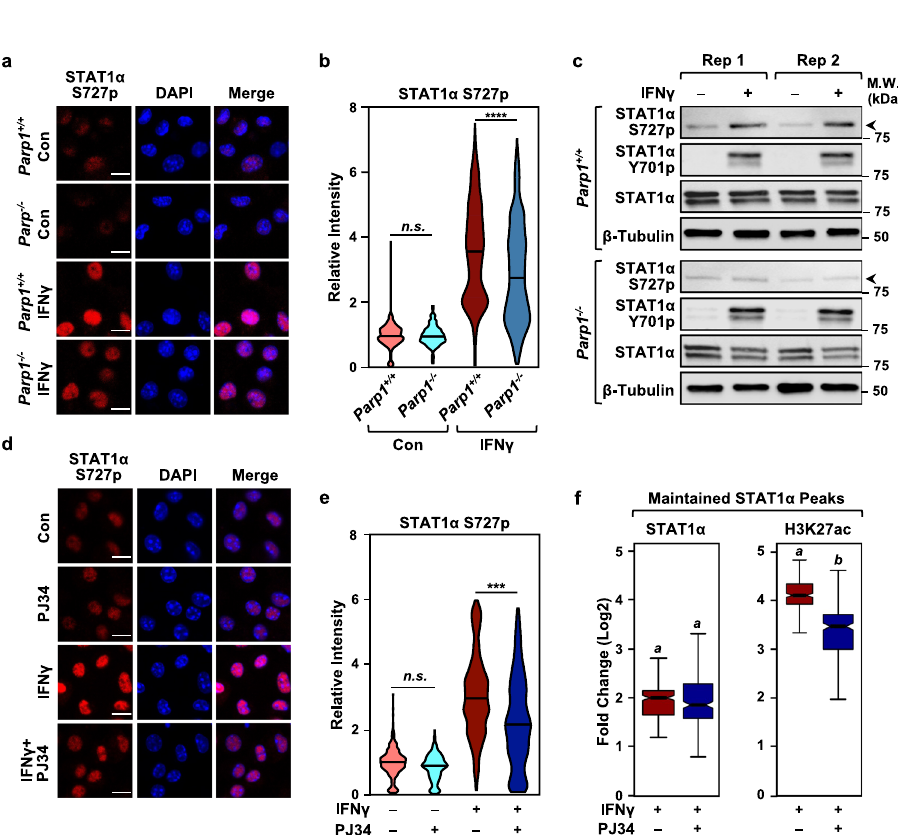
Fig. 3 PARP-1 catalytic activity promotes the phosphorylation of STAT1 α on Serine 727. a PARP-1 deletion attenuates STAT1 α phosphorylation at S727. Immuno fl uorescent staining for phospho-STAT1 α (S727p) was performed in BMDMs collected from wild-type ( Parp1 + / + ) or Parp1 knockout ( Parp1 -/- ) mice treated with IFN γ (1 h). Nuclei were visualized with DAPI staining. Scale bar: 10 μ m. b Violin plots showing quanti fi cation of the immuno fl uorescence data from ( a ) in BMDMs from Parp1 + / + ( n = 3) and Parp1 -/- ( n = 3) mice (one-way ANOVA followed by Tukey ’ s multiple comparison tests; **** < 0.0001; n.s., not signi fi cant at 0.05). c Immunoblots showing the relative levels of STAT1 α S727p, STAT1 α Y701p, total STAT1 α and Tubulin in BMDMs from Parp1 + / + and Parp1 -/- mice. Rep1 and Rep2 represent two independent biological replicates. Uncropped immunoblots are provided as a Source Data fi le. d Inhibition of PARP-1 catalytic activity by PJ34 blocks STAT1 α S727 phosphorylation. Immuno fl uorescent staining was performed as in ( a ). BMDMs were treated with IFN γ (1 h) ± PJ34. Nuclei were visualized with DAPI staining. Scale bar: 10 μ m. e Violin plots showing quanti fi cation of the immuno fl uorescence data from ( d ) for BMDMs from 3 mice for each treatment (one-way ANOVA followed by Tukey ’ s multiple comparison test; *** < 0.0001). f Inhibition of PARP-1 catalytic activity by PJ34 results in reduced enrichment of H3K27ac (right) levels at maintained STAT1 α binding sites (left) . ChIP-seq for STAT1 α and H3K27ac was carried out in BMDMs treated with IFN γ (1 h) ± PJ34 ( n = 252 peaks; Wilcoxon Signed-Rank test; p < 2.2 × 10 -16 ). Boxes represent 25 th – 75 th percentile (line at median) with whiskers at